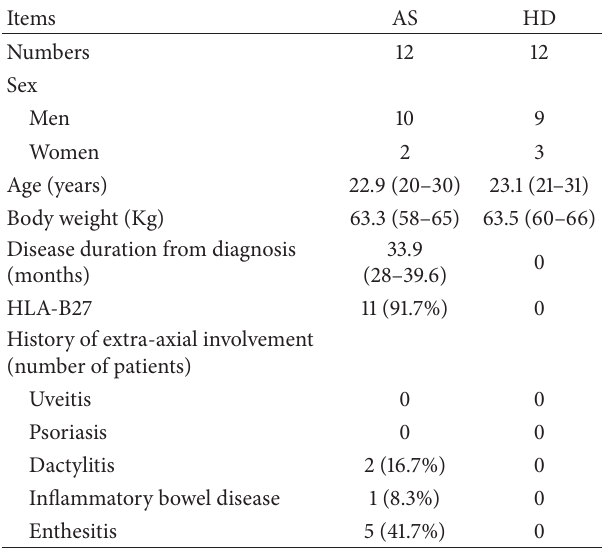
Table 1: Demographic data and disease characteristics of enrolled patients and healthy